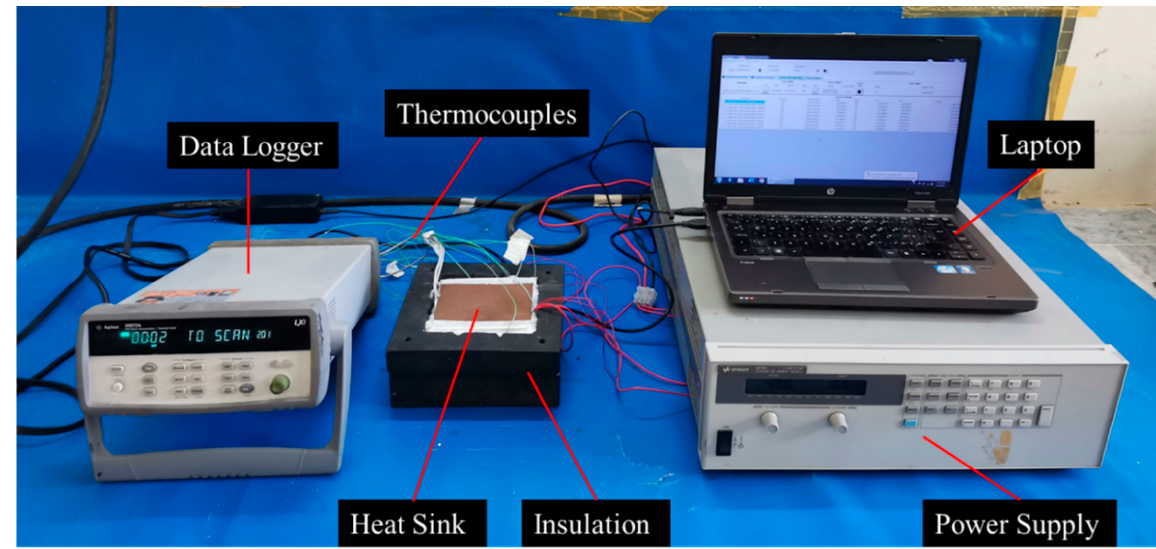
Figure 2. Photographic View of Experimental Setup.